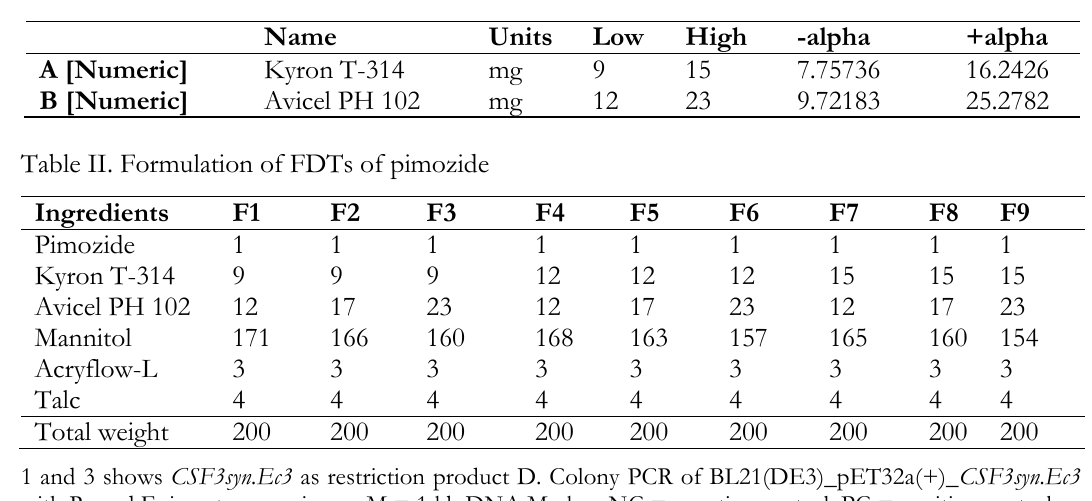
Table I. Level of formulation variables